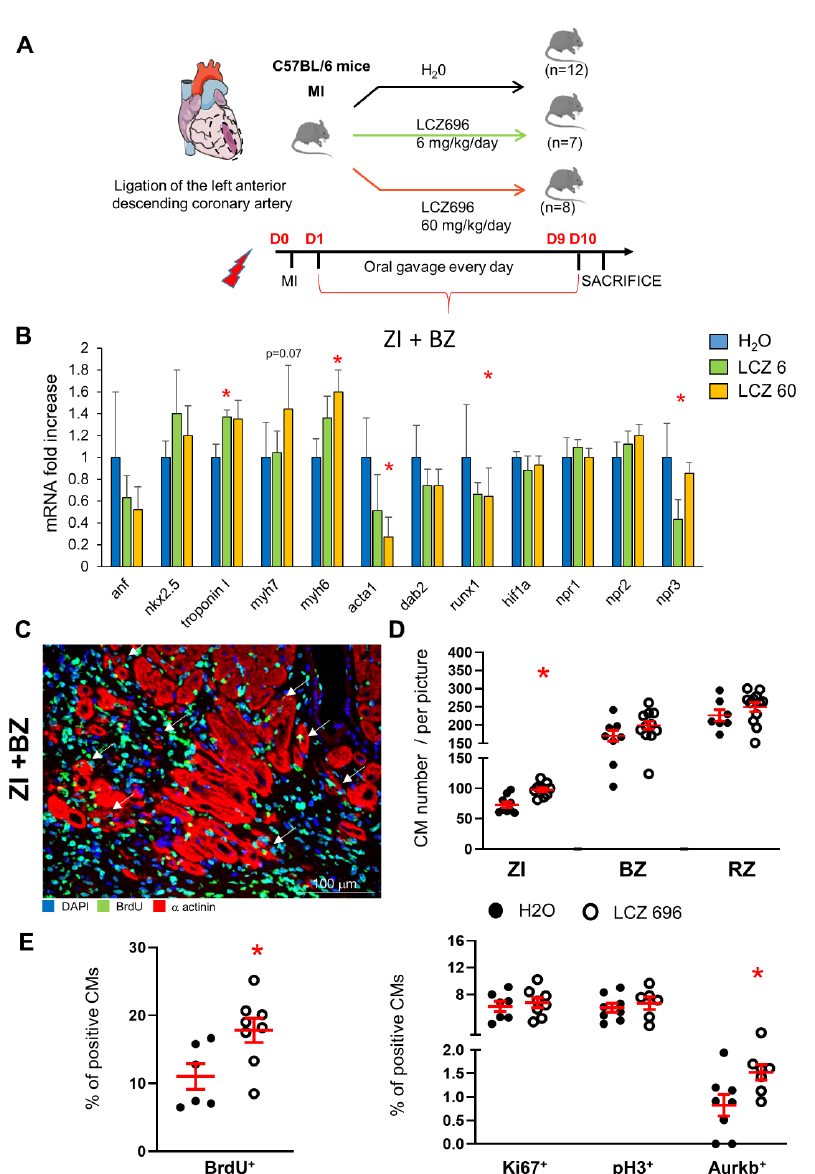
Figure 7. LCZ696 treatment increases the cardiomyocyte number in the infarct and border area of infarcted hearts. ( A ) Experimental protocol as described in detail in the Material and Methods section. ( B ): Quantitative relative expression of mRNAs coding for cardiomyocyte specific genes in the border zone of the infarcted hearts treated or not with LCZ696 at two different doses for 10 days. ZI: infarct zone, BZ: border zone, RZ: remote zone. Results expressed as fold-increase above the levels in untreated infarcted hearts (H 2 O). Results represented as means ± SEM; n = 12 for H 2 O treated mice, n = 7 for LCZ696 6 mg/kg/day and n = 8 for LCZ696 60 mg/kg/day treated mice. anf: atrial natriuretic peptide; myh7: β Myosin heavy Chain; myh6: α Myosin heavy Chain; acta1: skeletal muscle alpha-actin; hif1 α : hypoxic inducible factor 1 α ; npr1, 2 or 3: natriuretic peptide receptor A, B or C, respectively. ( C ) Representative picture of immunostainings using antibodies against α actinin and BrdU of the infarct and border area of a LCZ696-treated hearts. White arrows depict BrdU positive cardiomyocytes, which are dedifferentiated small CMs. ( D ) CM number counted in the different area of the infarcted hearts treated or not with LCZ696 (no difference between both doses, the results are pooled). At least 10 different pictures counted per area and heart. n = 7–9 H 2 O- and 9–12 LCZ696-treated infarcted hearts. Number of CMs in LCZ696-treated hearts related to the numbers found in H 2 O-treated infarcted hearts. ( E ) Percentages of CMs expressing BrdU, Ki67, pH3 and Aurora B in the infarcted and border area of the injured hearts. At least 10 different pictures counted per mouse. n = 6–8 H 2 O-or LCZ696-treated infarcted hearts. ( D , E ) Individual values represented and the means ± SEM depicted in red. * p < 0.05 versus untreated infarcted